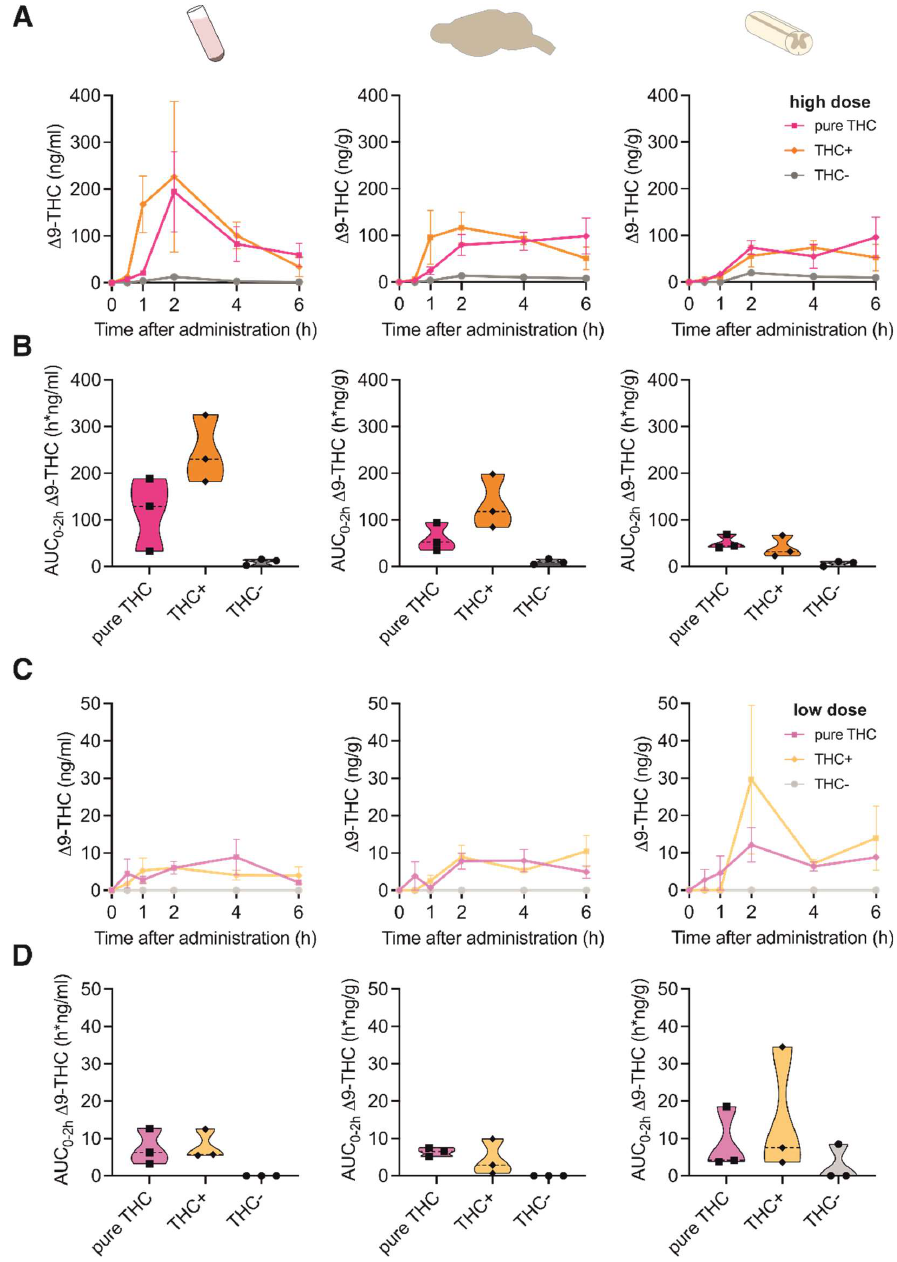
Figure 1. Pharmacokinetic profile of ∆ 9-THC following oral administration of high and low doses of cannabis extracts and pure THC compound. ( A ) Concentration-time profiles of ∆ 9-THC in plasma, brain and spinal cord at 0, 1, 2, 4 and 6 h after oral administration of 20 mg/kg pure THC compound, 40 mg/kg THC+ extract and 1560 mg/kg THC- extract. Data are represented as mean ± SEM, n = 3 per timepoint. ( B ) Area under the curve (AUC) of ∆ 9-THC concentrations calculated for the time period 0–2 h after administration for data shown in ( A ) (AUC 0–2h ). ( C ) Concentration-time profiles of ∆ 9-THC plasma, brain and spinal cord at 0, 1, 2, 4 and 6 h after oral administration of 1 mg/kg pure THC compound, 2 mg/kg THC+ extract and 40 mg/kg THC- extract. Data are represented as mean ± SEM, n = 3 per timepoint. ( D ) AUC 0–2 h of ∆ 9-THC concentrations calculated for data shown in ( C